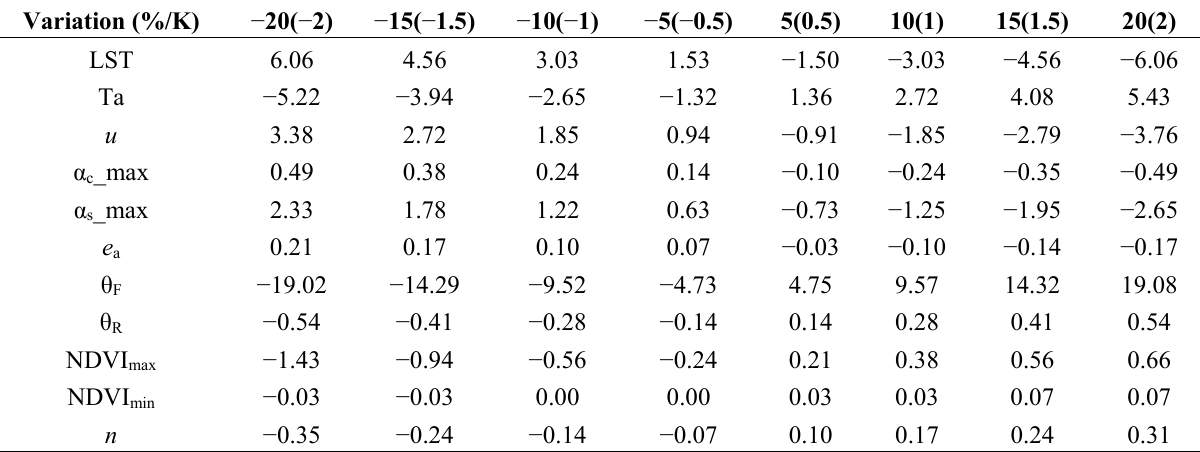
Table 2. Relative sensitivity of estimated surface soil moisture from the trapezoidal method to input variables at the SMTMN site on 2 September 2010.Numberswithin each bracket indicate variations in temperature variables ( i.e ., − 2 °C–2 °C), and numbers outside each bracket show variations in other variables ( i.e ., −